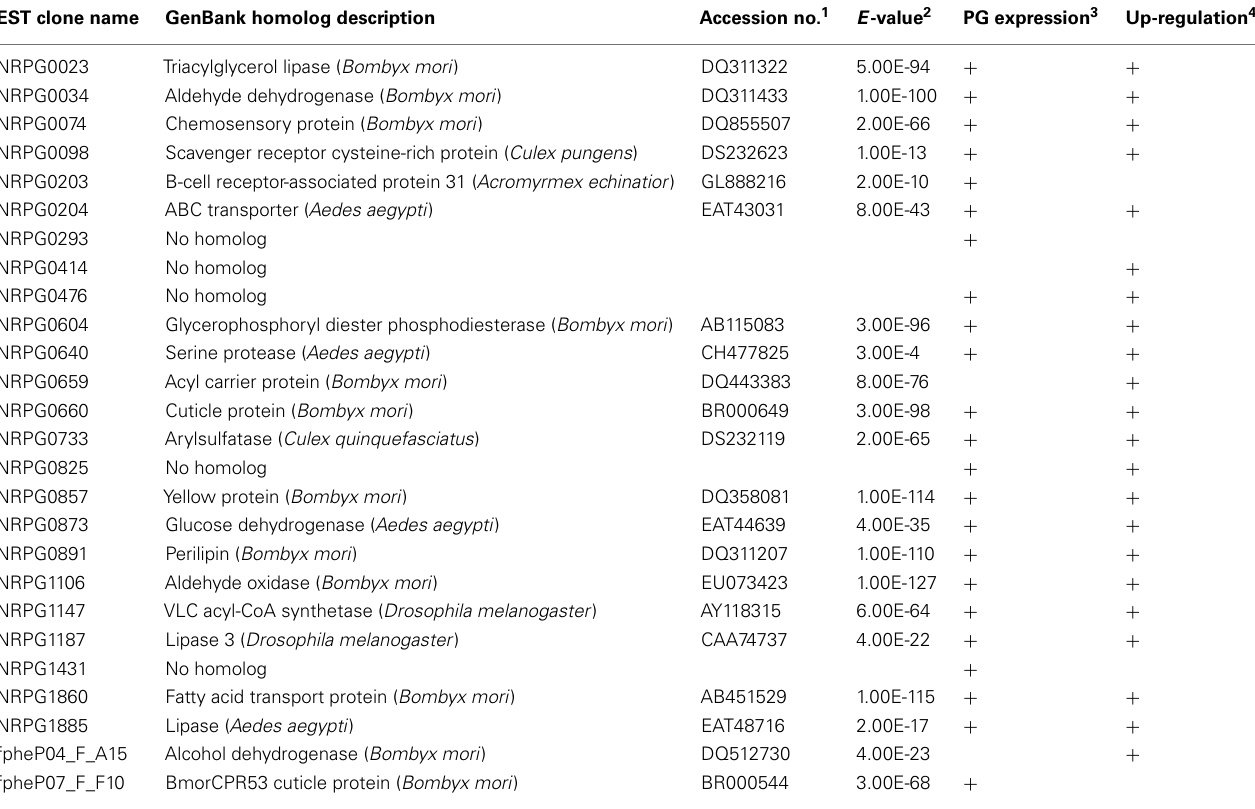
Table 1 | Expressed-sequence tag clones identified in the Bombyx mori pheromone